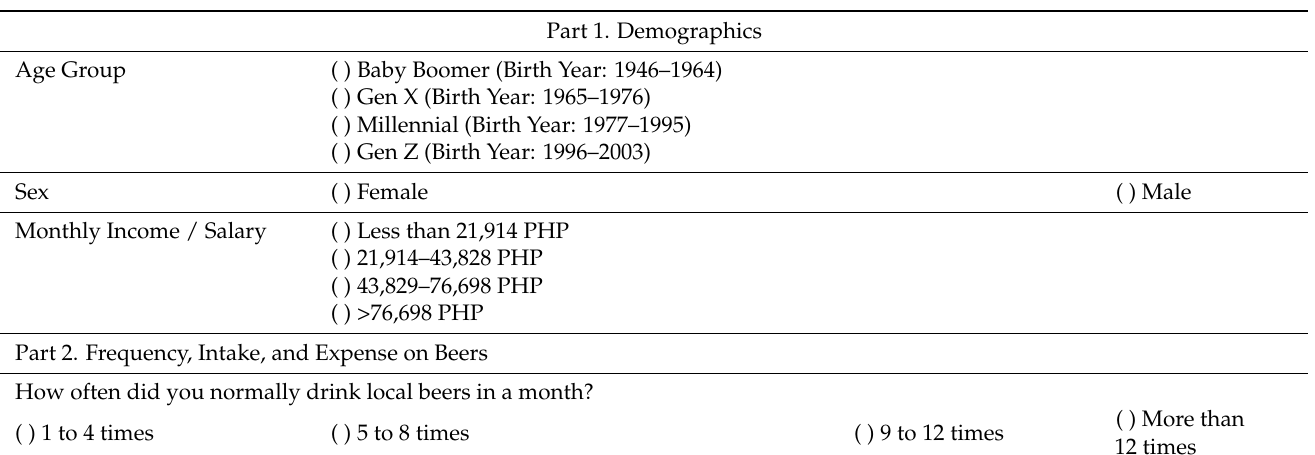
Table A1. Questionnaire used during the survey